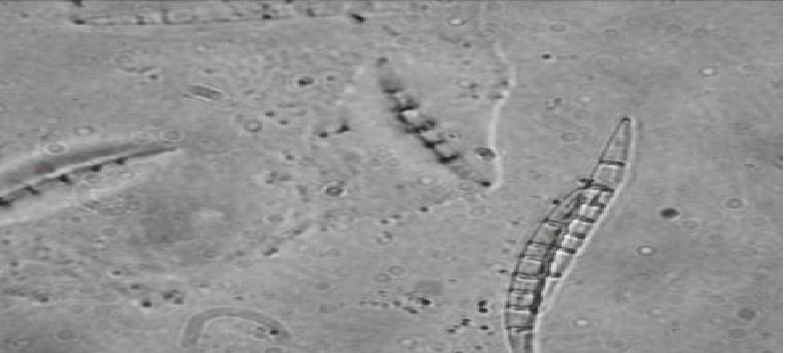
Figure 1. Microdochium nivale (Fr.) Samuels and I.C. Hallett (a.k.a Fusarium nivale (Fr.) Ces.ExBerl. and Voglino) conidia (scale bar: 10 µm).